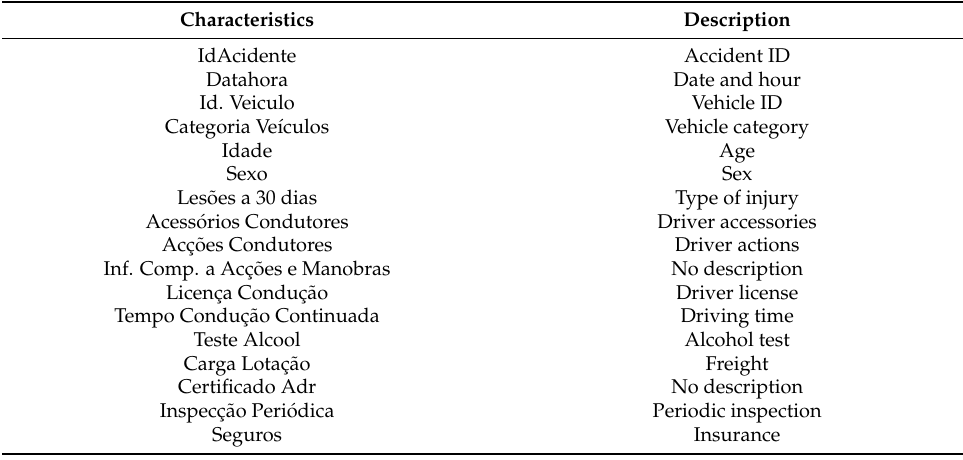
Table 4. Vehicles involved data